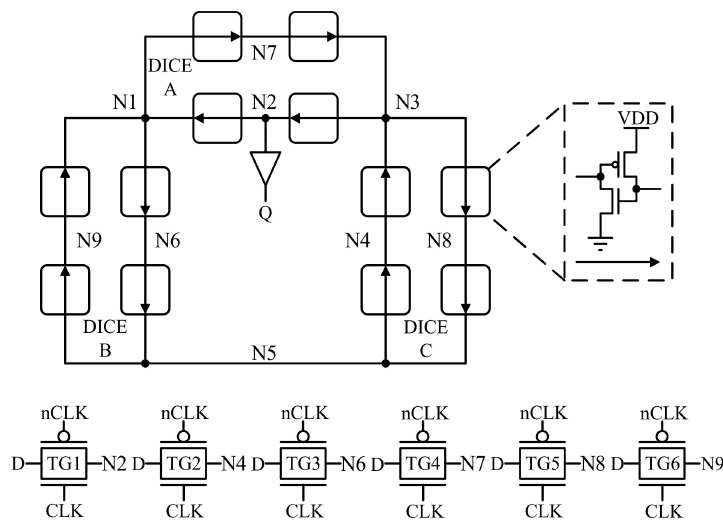
Figure 5. Schematic of Delta DICE